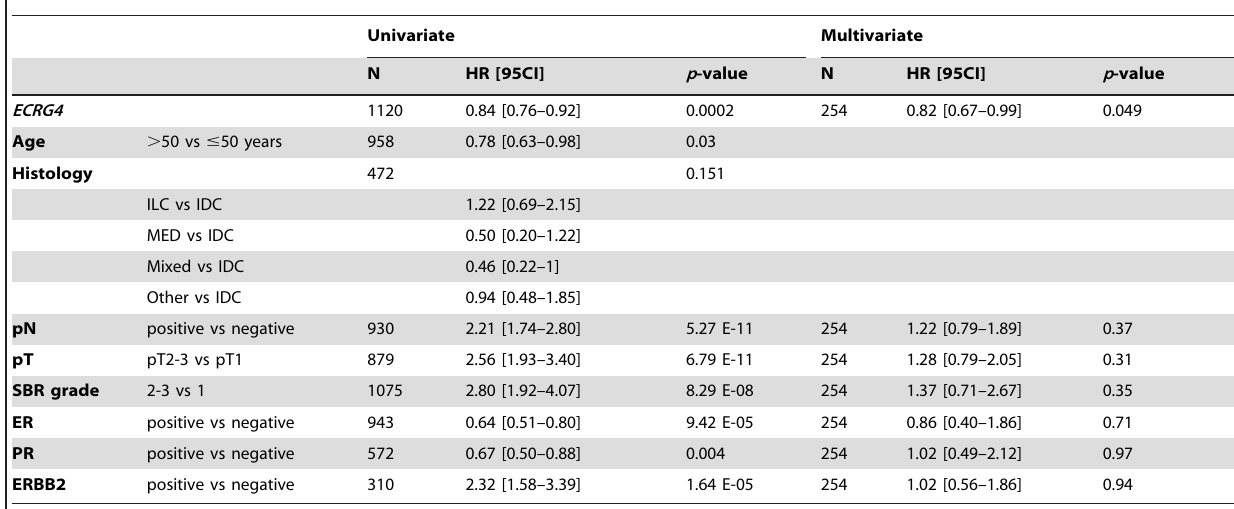
Table 3. Disease-free survival (DFS), Cox regression